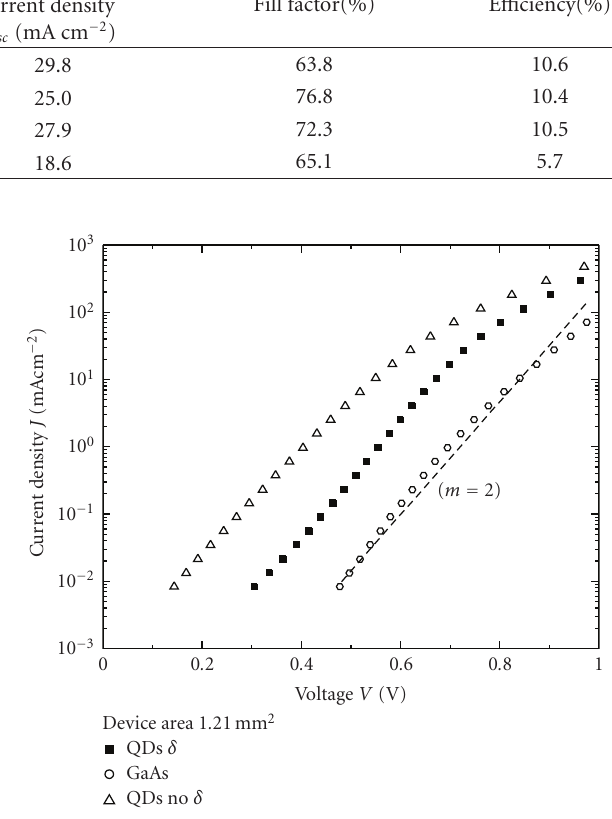
Figure 12: The dark current density-voltage characteristics of GaAs reference cell, GaAs IBSC solar cells based on quantum dot with and without delta ( δ ) doping of quantum dot layers (from